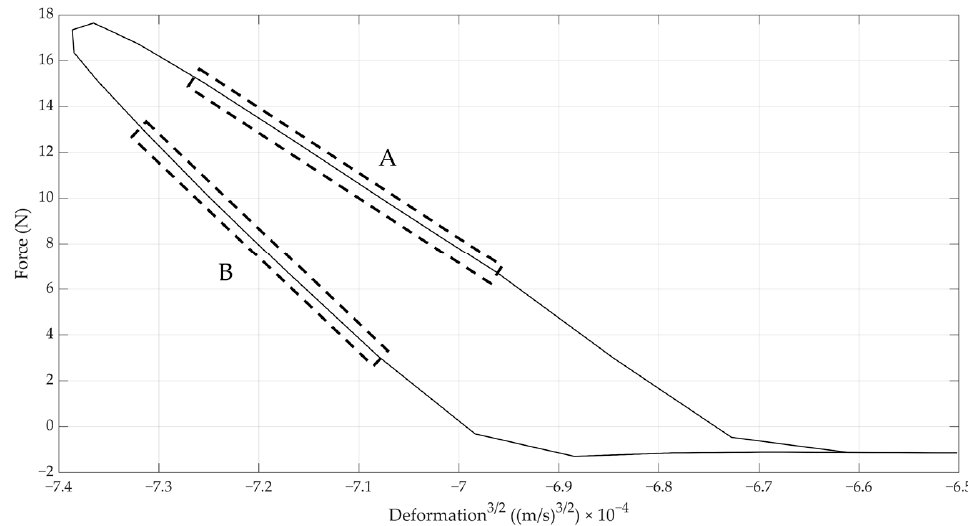
Figure 4. Loading ( A ) and unloading ( B ) of the egg by the steel ball. Linear regions as expected based on Hertz theory are highlighted.